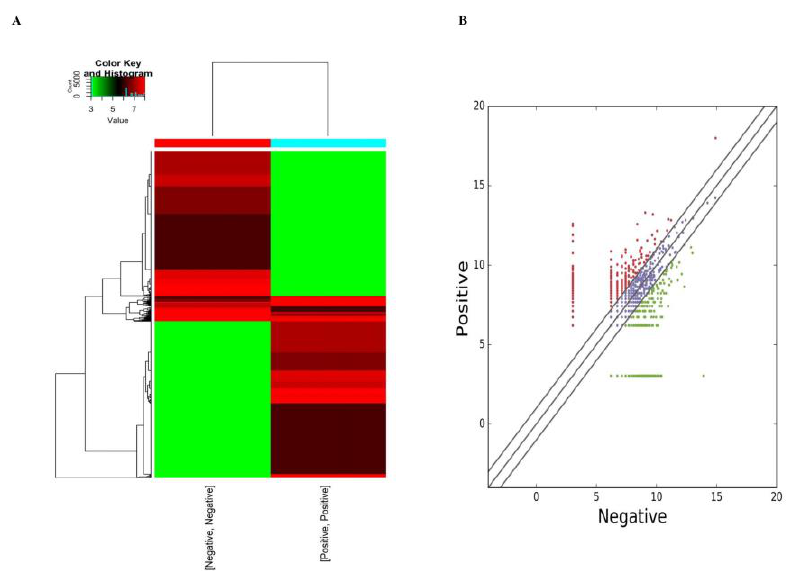
Figure 7. Oar-miRNA-125b potentially binding DEcircRNA. ( A ) Heat map of 3040 DEcircRNA. Each column shows one sample and each row represents one circRNA. ( B ) Positive vs. negative DEcircRNA scatter plots. Red dots indicate upward adjustment, turquoise dots indicate downward adjustment.